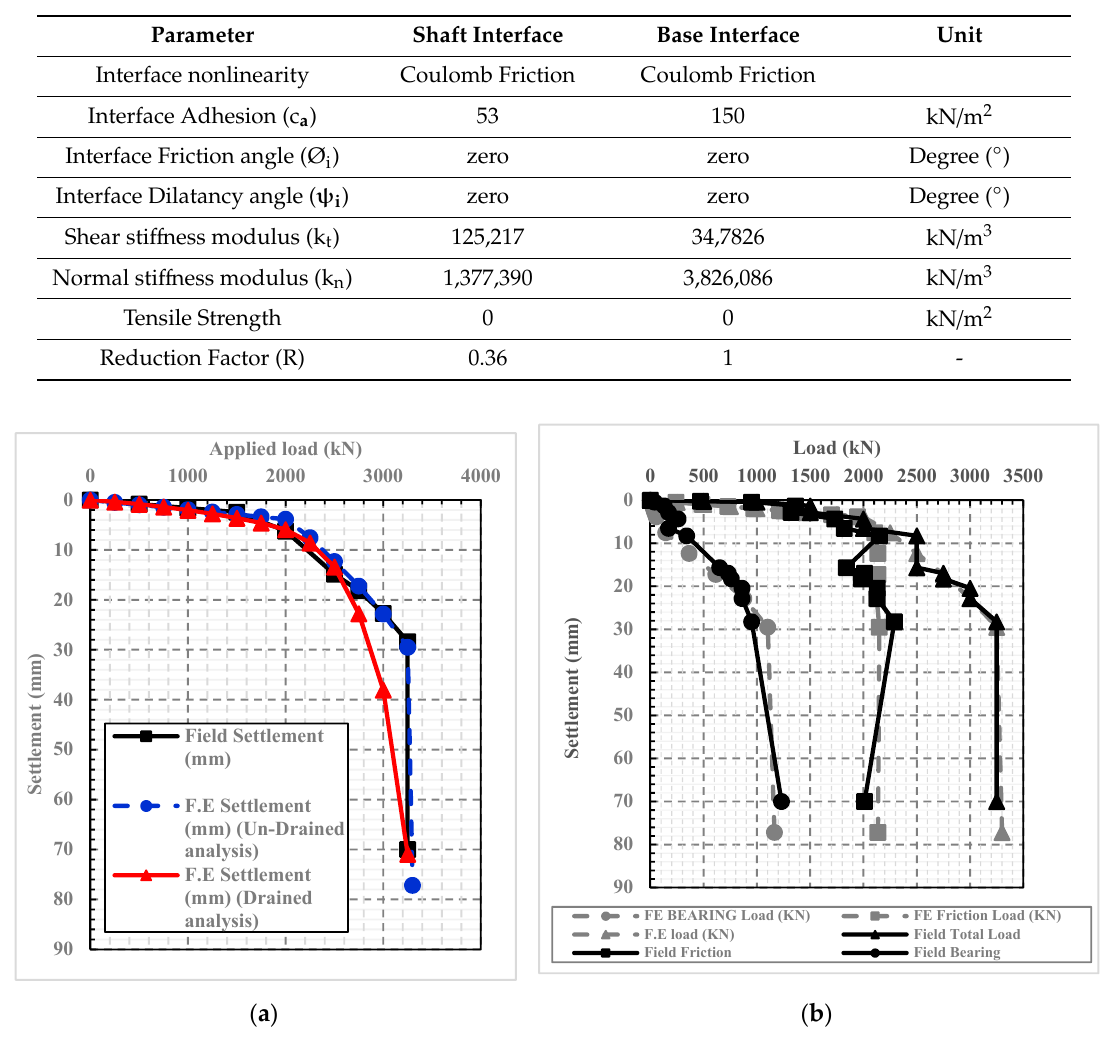
Figure 11. Comparison between field measurements and results of the undrained numerical analysis ( a ) pile settlement results. ( b ) Pile load transfer results.